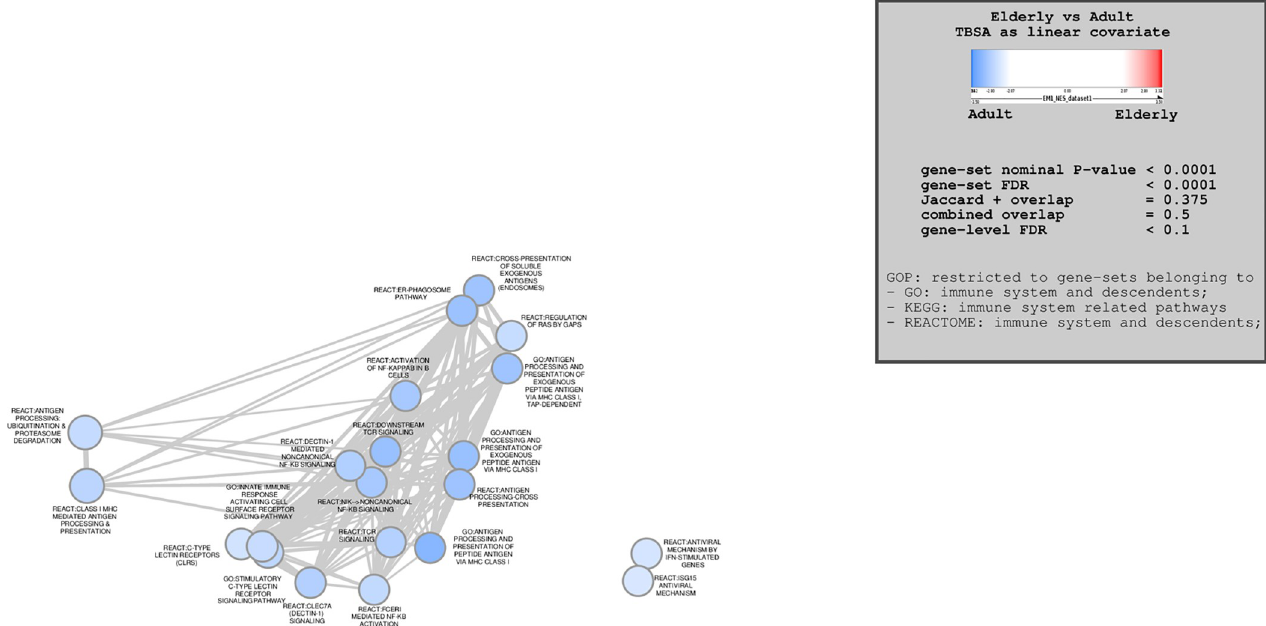
Fig 1. Enrichment map outlining significantly altered immune-related pathways for comparison group 1 (TBSA as a linear covariate). Blue nodes represent pathways downregulated in the elderly group, red nodes represent pathways upregulated in the elderly group. Node size is proportional to gene set